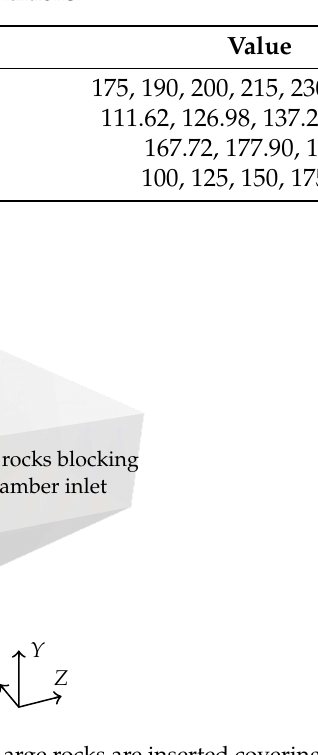
Table 5. Operating parameters and simulation conditions.